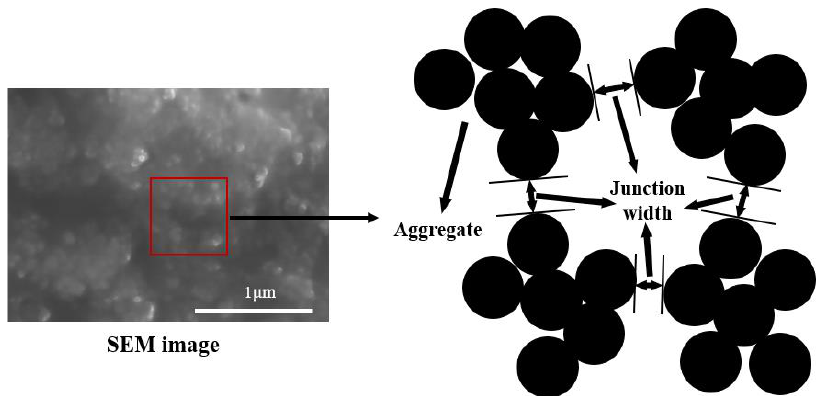
Figure 2. Schematic diagram of CNPs − filled polymer. (The red box means the local area of the SEM image can be represented by the schematic diagram on the